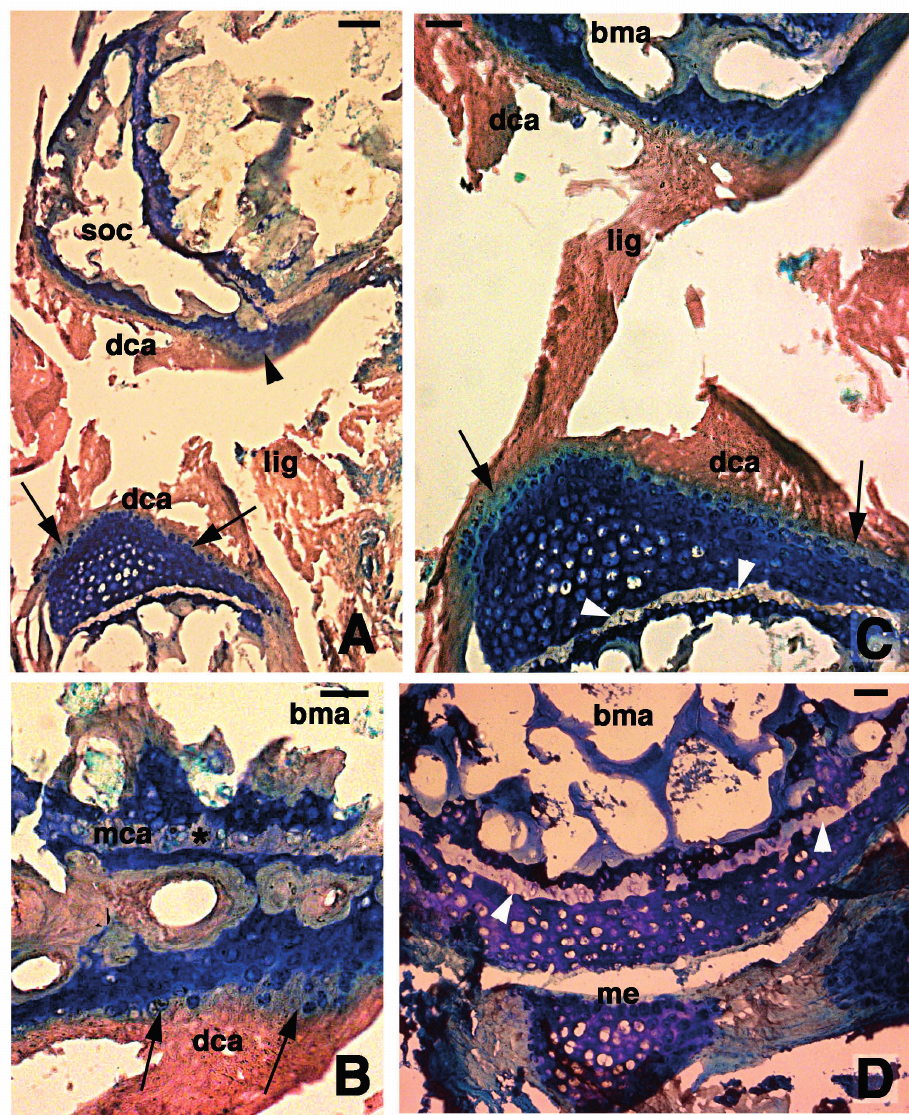
Figure 3. Histological aspects of the knee 7 days after the lesion. ( A ) Degenerating articular cartilage surface of the femur (arrowhead) while a region of regenerating cartilage is seen in the tibia (arrows) localized beneath the degenerated and eosinophilic articular cartilage with fragments of ligaments/meniscus. Bar, 100 µm; ( B ) Detail of the degenerated femur eosinophilic cartilage, in continuation with degenerating (pyknotic) chondrocytes (arrows). Also part of the metaphyseal plate appears to be degenerating (asterisk). Bar, 50 µm; ( C ) Detail on the ligament connection between the regenerated tibia cartilage (arrows) and the degenerating cartilage in the femur. Bar, 25 µm; ( D ) Case showing regeneration in the articular cartilage of the femur although a region of degenerated and chromophobic cartilage is still present in part of the metaphyseal plate. Bar, 25 µm. Legends : bma, bone marrow; dca, degenerated cartilage; lig, ligament; me, meniscus; mca, metaphyseal plate; soc, secondary ossification